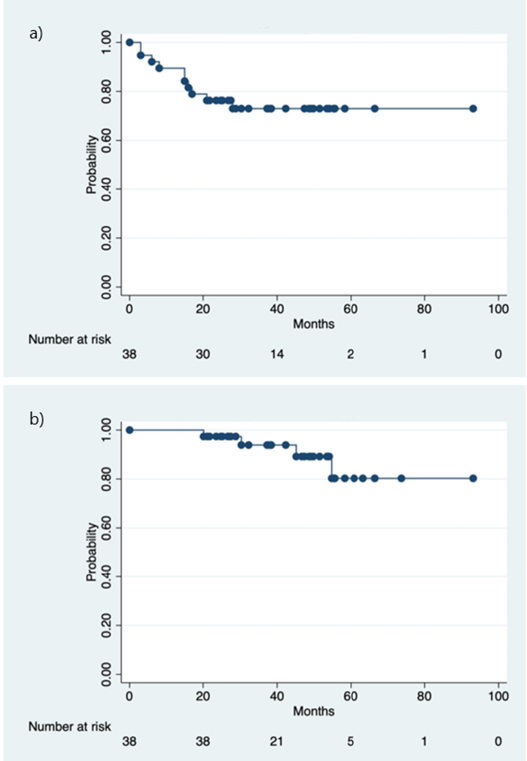
J. Clin. Med. 2022 , 11 , 4450 Figure 1. The cumulative 5-year biochemical-progression free survival ( a ) and overall survival ( b ).